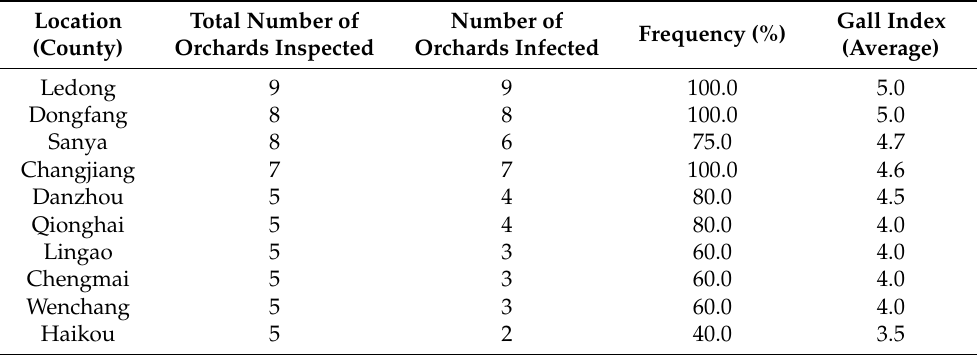
Figure 1. Symptoms induced by root-knot nematodes in red dragon fruit plants. ( A ) Infested dragon fruit plant; ( B – D ) Infected plant roots showing galls and egg masses; ( E , F ) Decayed root and pear- shaped females. ( G – I ) Root slices showing swollen nematodes (n) and giant cells (*). The scale bars indicate 100 µ m. Table 2. Frequency and severity of root-knot nematodes on red dragon fruit plants in different counties in